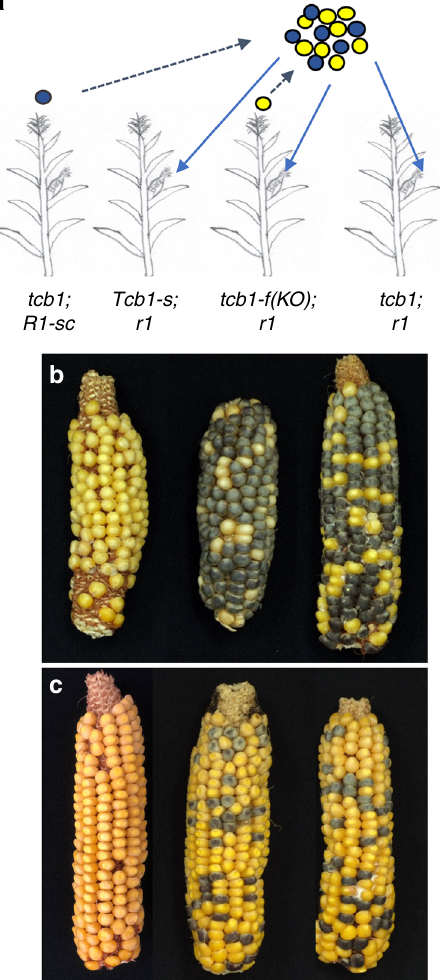
Fig. 1 Mixed pollination test of the Tcb1-f mutants. a Scheme of the experiment: Two pollen donor lines and three pollen receiver lines were used. Pollen from a tcb1; R1-self color maize line (purple circles), produces purple kernels, while pollen from test plants (yellow circles) produces white or yellow kernels. Pollen from the two donors was mixed and put on three receiving ears: (1) Tcb1-s ears to verify the Tcb1-male function from the KO line; (2) tcb1-f(KO) ears to test the presence/absence of the female barrier in the knockout mutant individuals; and (3) a maize ( tcb1; r1 ) neutral ear to identify the ratio of viable pollen grains from the two donors in the mixture. b Ears from the three pollen recipients for the tcb1-f(KO1) ) test. c Ears from the three pollen recipients for the tcb1-f(KO2) test. In both tests, pollen from the KO plants successfully fertilized the Tcb1-s ear (left ear in b and c ), while the ears from KO plants showed no barrier to tcb1 maize pollen with a similar frequency of purple kernels on mutant ears and the neutral test ears (middle and right ears in b and c